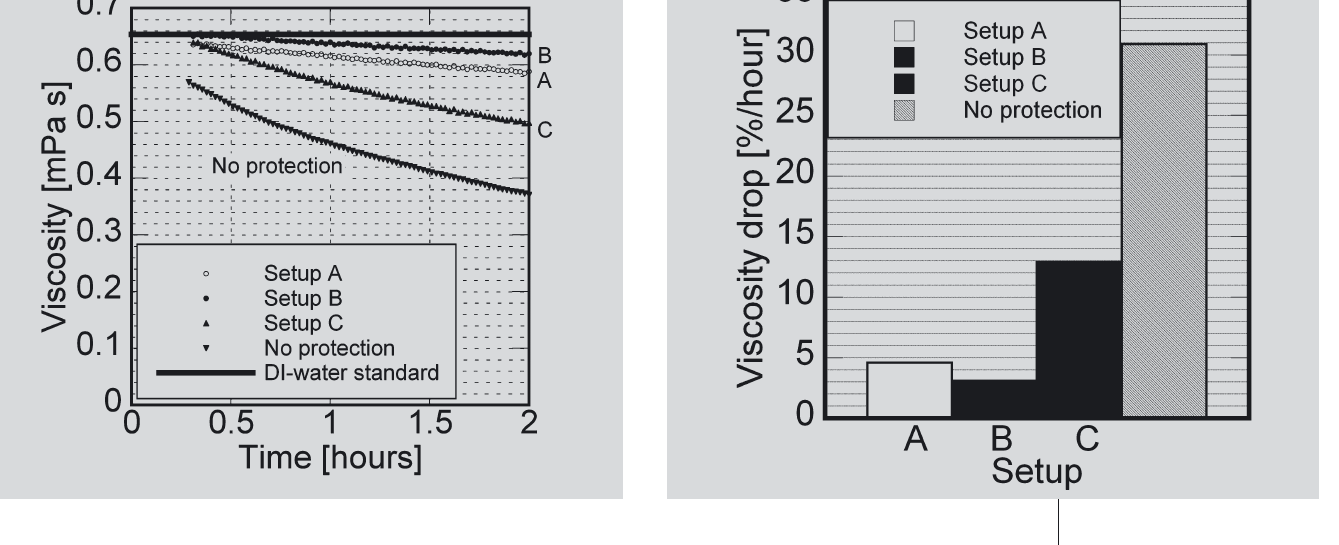
Figure 2a (left): Transient viscosity of DI water at 500 s -1 and 40°C with different setups. Figure 2b: Rate of viscosity decrease for DI water at 40°C for different